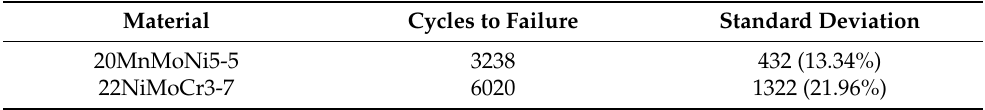
Table 4. Results of Preliminary